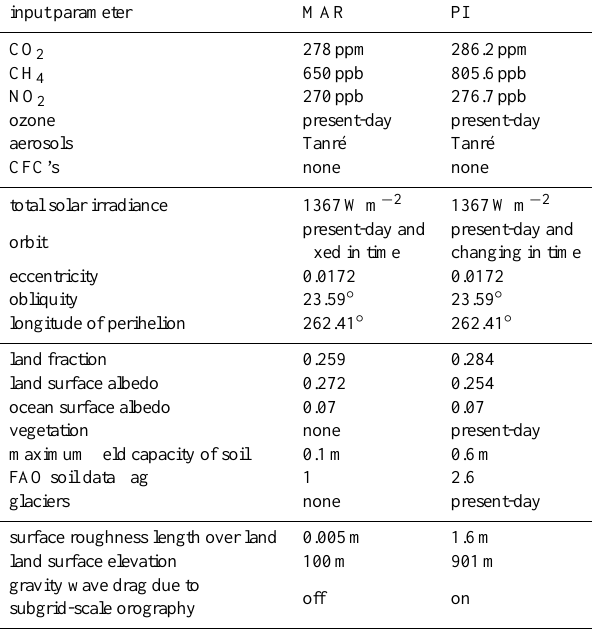
Table 1. ECHAM5 input parameters for the Marinoan control sim- ulation MAR and the pre-industrial control simulation PI. MAR uses a fixed orbit whose parameters are chosen to match the tem- porally varying orbital parameters of PI at year 800AD. PI uses the VSOP87 orbit (Variations S´eculaire des Orbites Plan´etaires) of Bre- tagnon and Francou (1988), values given here are for year 800AD according to Berger (1978) and are taken from http://aom.giss.nasa. gov/srorbpar.html. Land surface albedo, soil data and land surface roughness length are globally uniform in MAR but vary spatially in PI; for the latter mean values are given. MAR’s FAO soil data flag corresponds to sand. The pre-industrial control simulation is the same as in Voigt and Marotzke